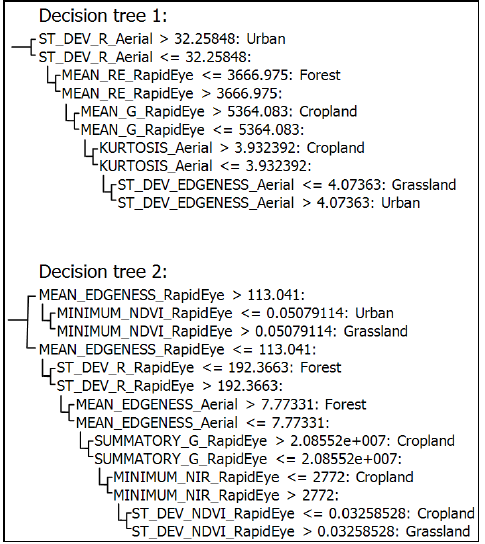
Figure 1. Two first decision trees used in the classification of the objects combining the aerial and the RapidEye images.